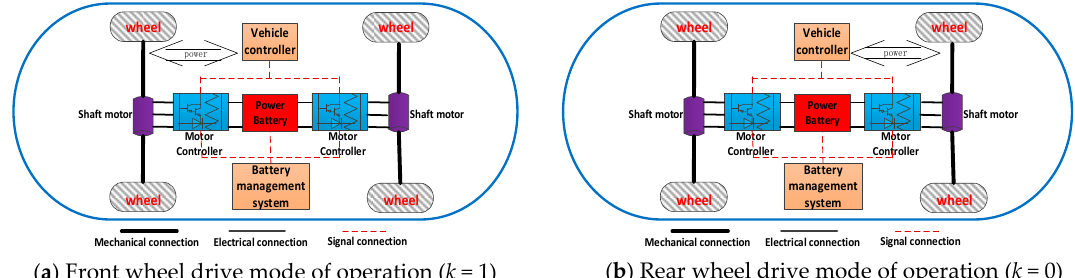
Figure 1. Front/rear wheel independent drive mode.